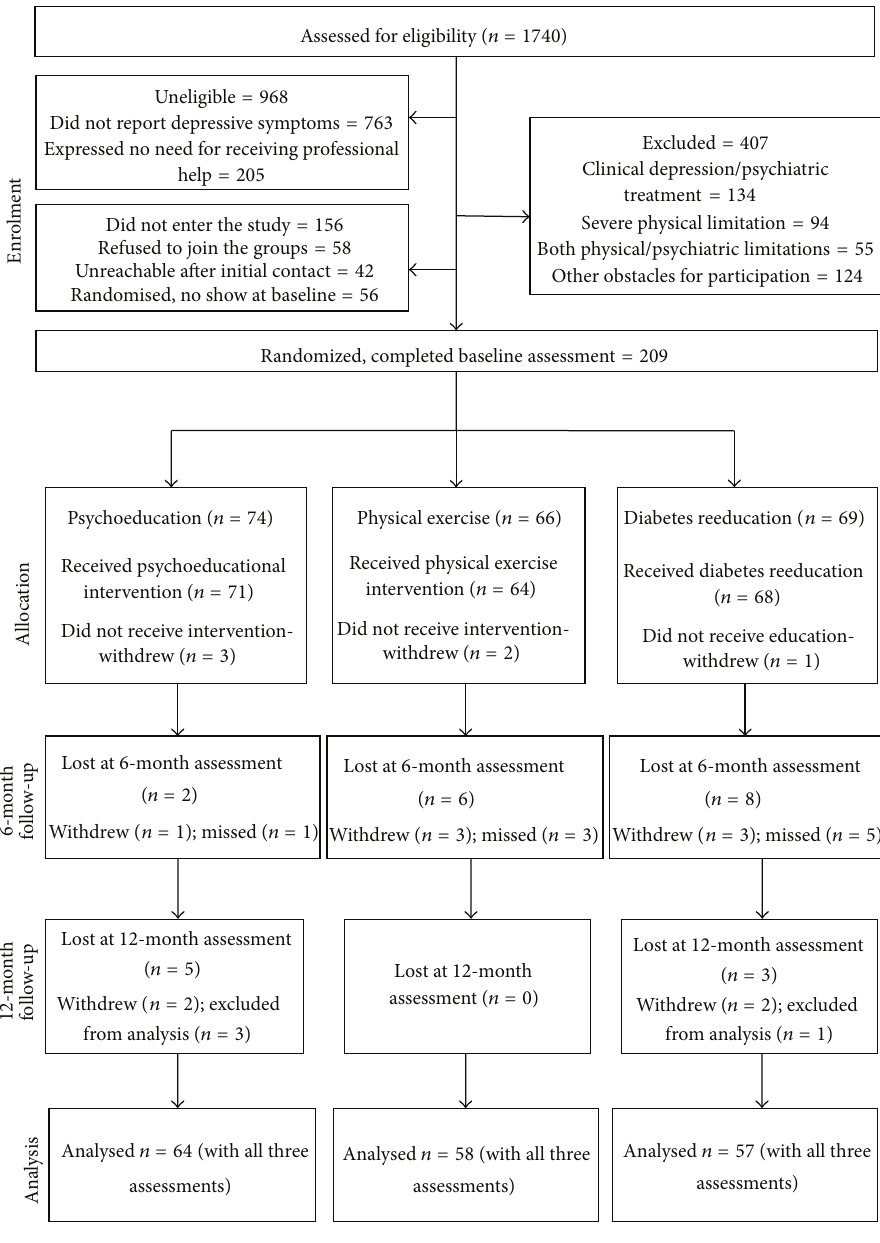
Figure 1: Patients’ flow